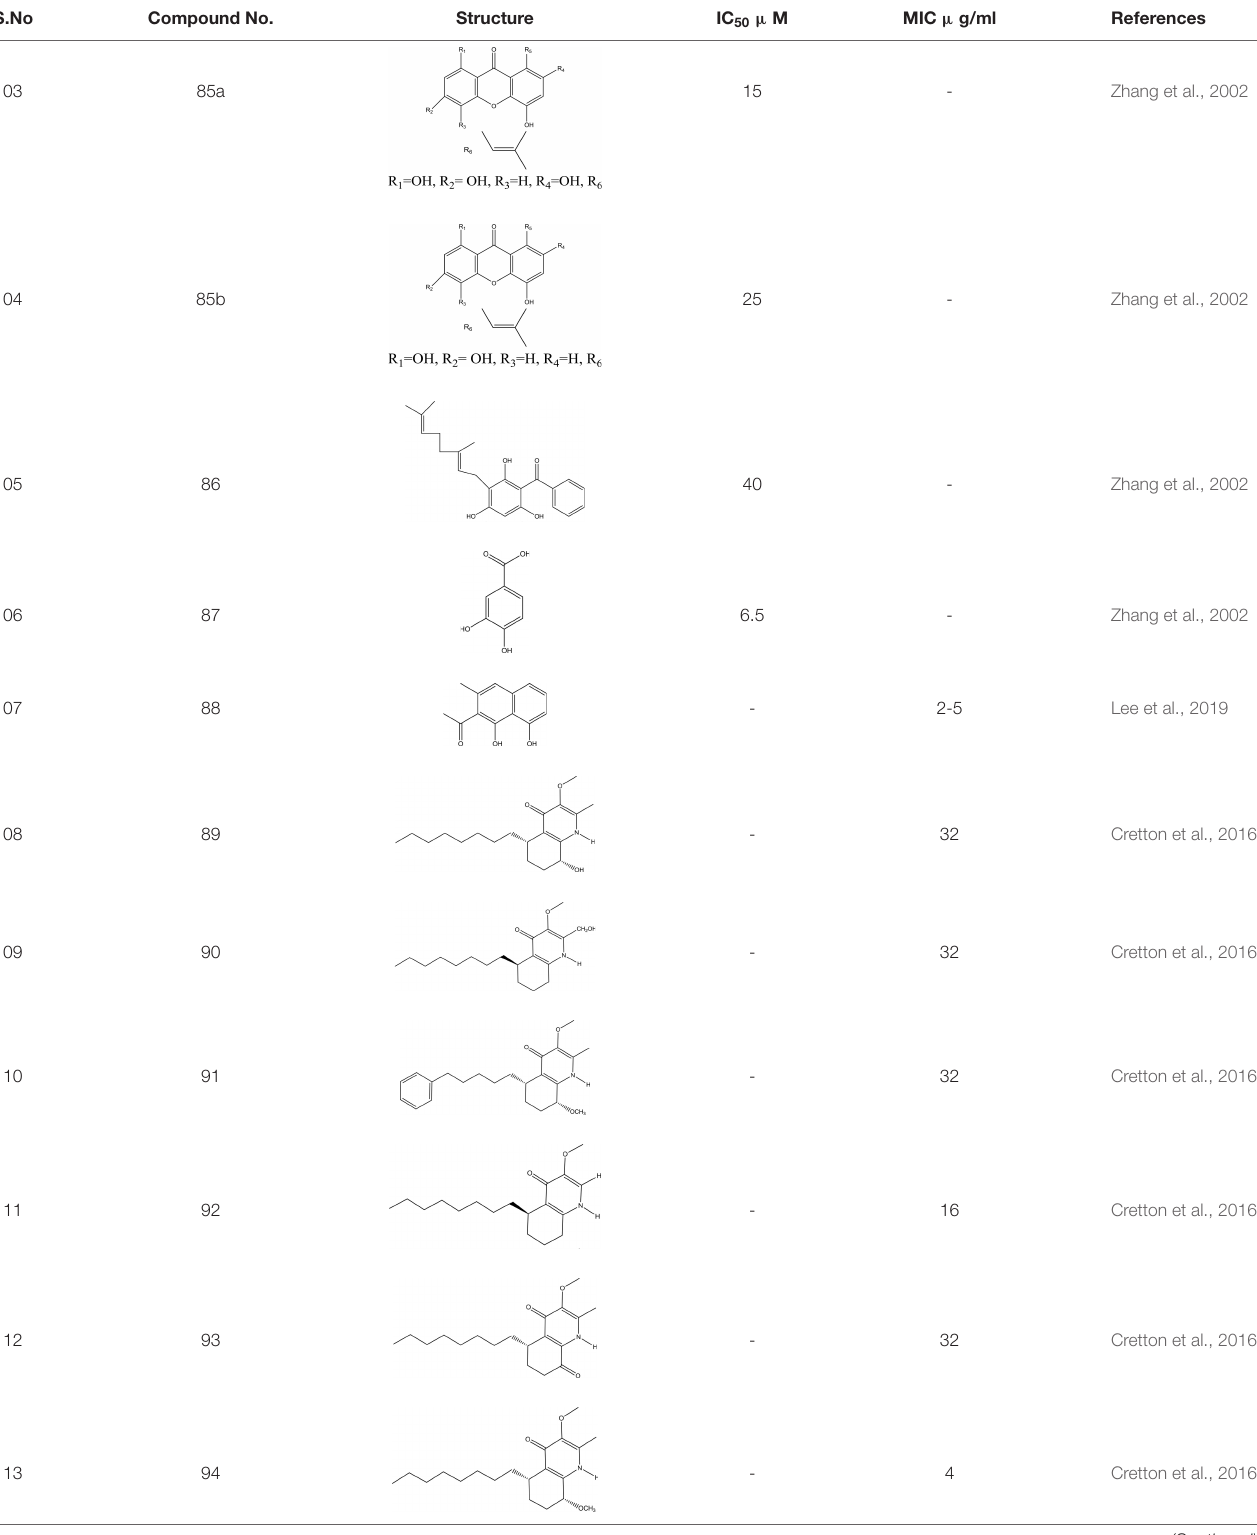
TABLE 6 | Chemical structures and MIC/IC 50 values of small molecule inhibitors (85–98). S.No Compound